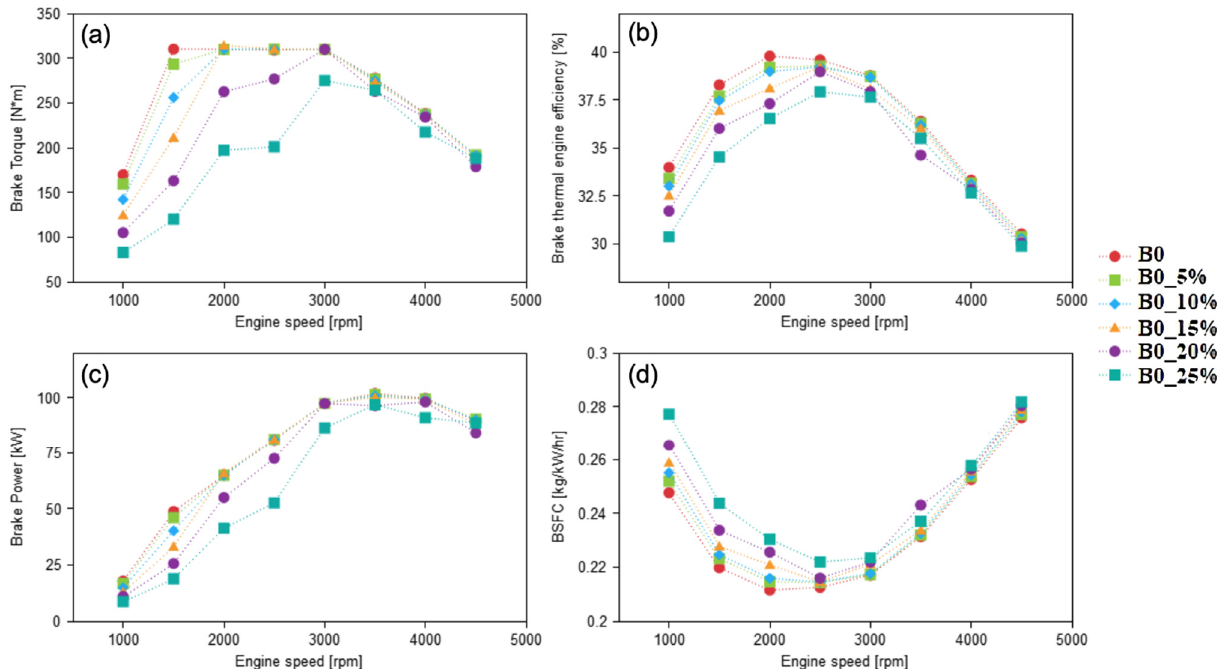
Figure 5. Comparison of ( a ) brake torque, ( b ) BTE, ( c ) brake power and ( d ) BSFC, for B0 LIVC oper- ation.